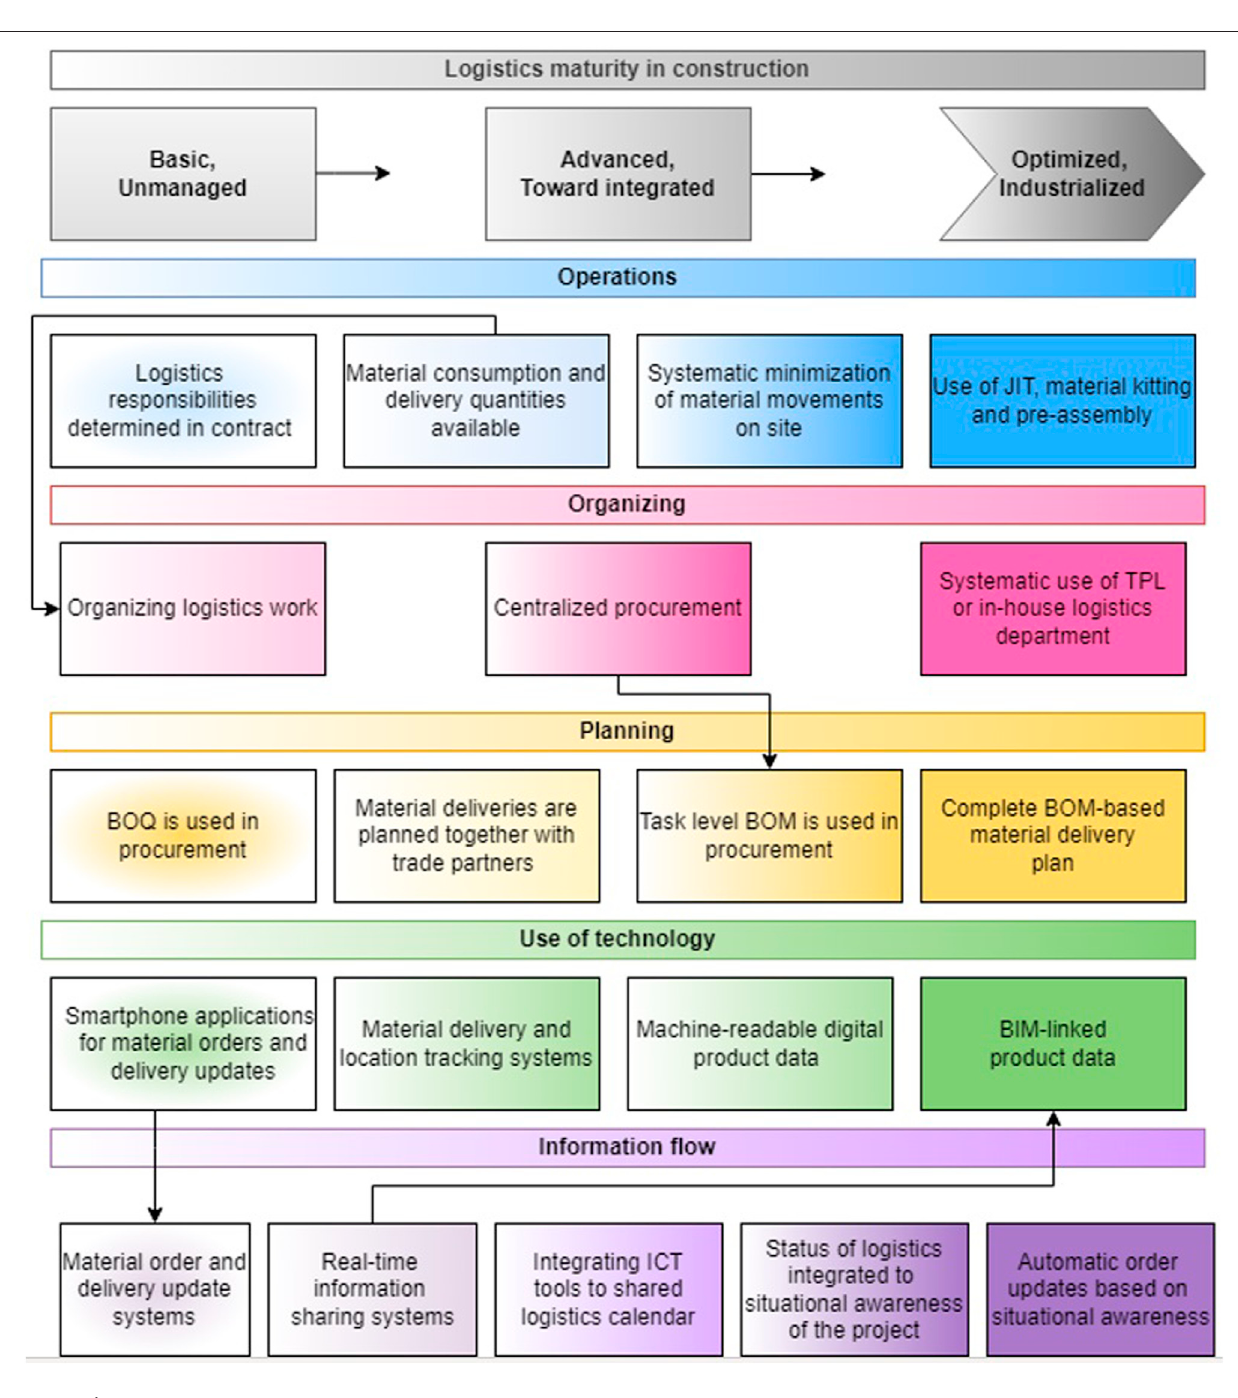
FIGURE 2 | Construction logistics maturity